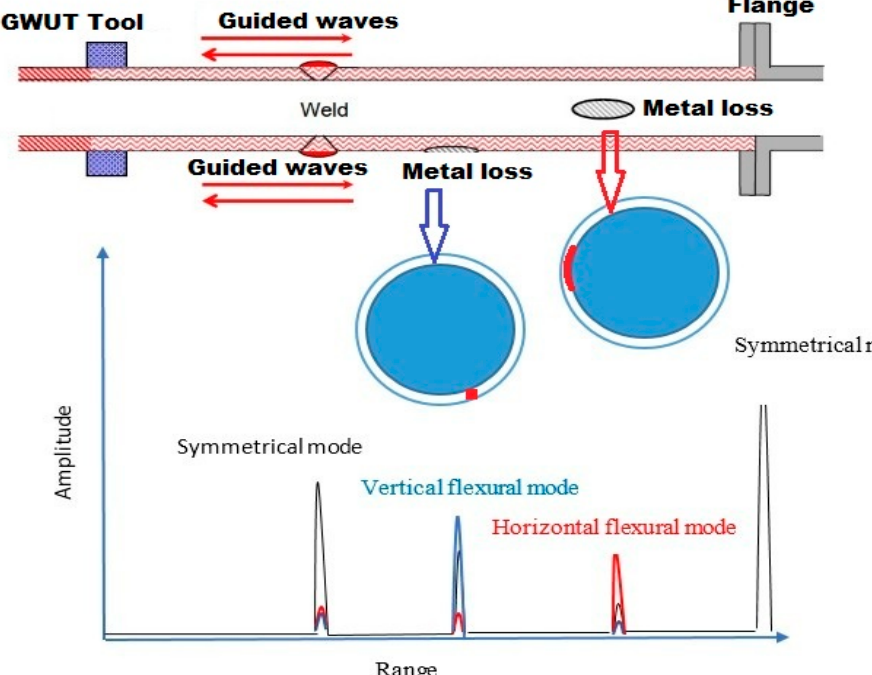
Figure 4. Propagation and reflection of GW in a pipe. The axisymmetric and non-axisymmetric horizontal or vertical flexural modes reflected from symmetric and non-axisymmetric pipe features, respectively.